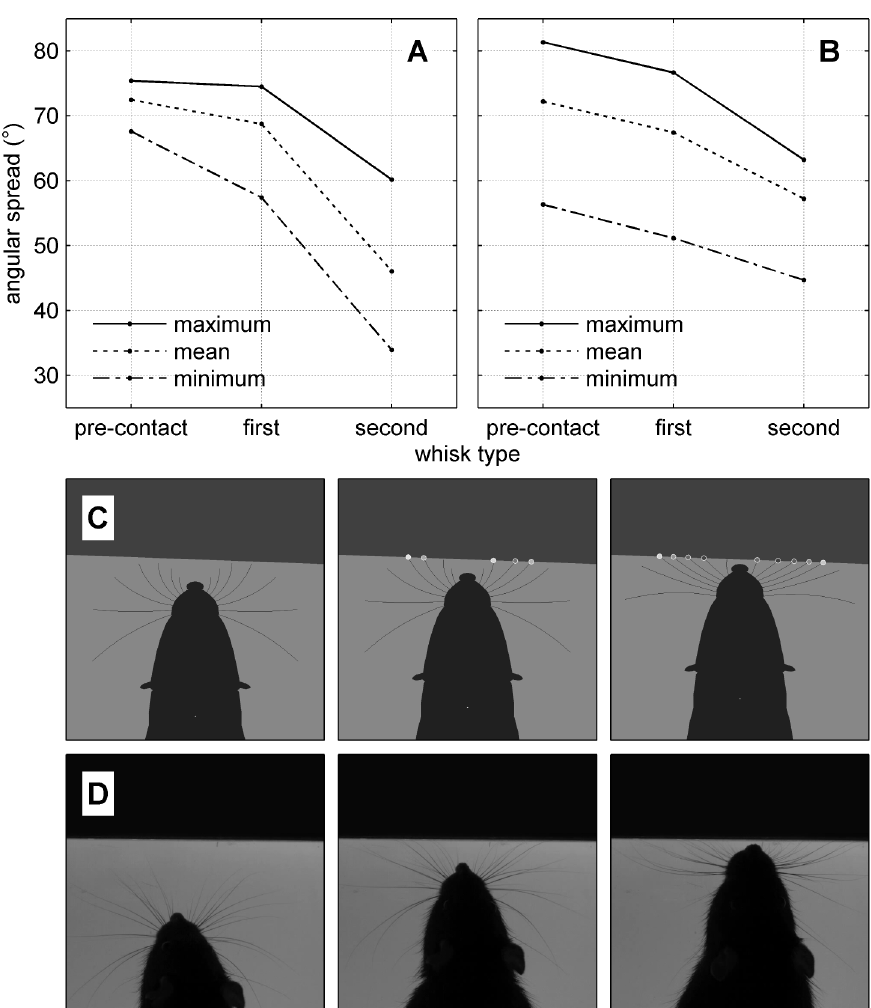
Figure 8. Spread-reduction. (A) Results from model. Solid/dotted/chained lines are maximum/mean/minimum spread within the whisk, against whisk type (see text). (B) Results from behavioural experiment (in rat, [23], their Figure 2b), data re-plotted. (C/D) Stills from model (C) and behavioural experiment (D) showing the trial condition of rat approaching vertical obstacle (three panels in each case show time of maximum protraction in pre- contact, first and second contact whisks). Stills in (C) are taken from Video S7.